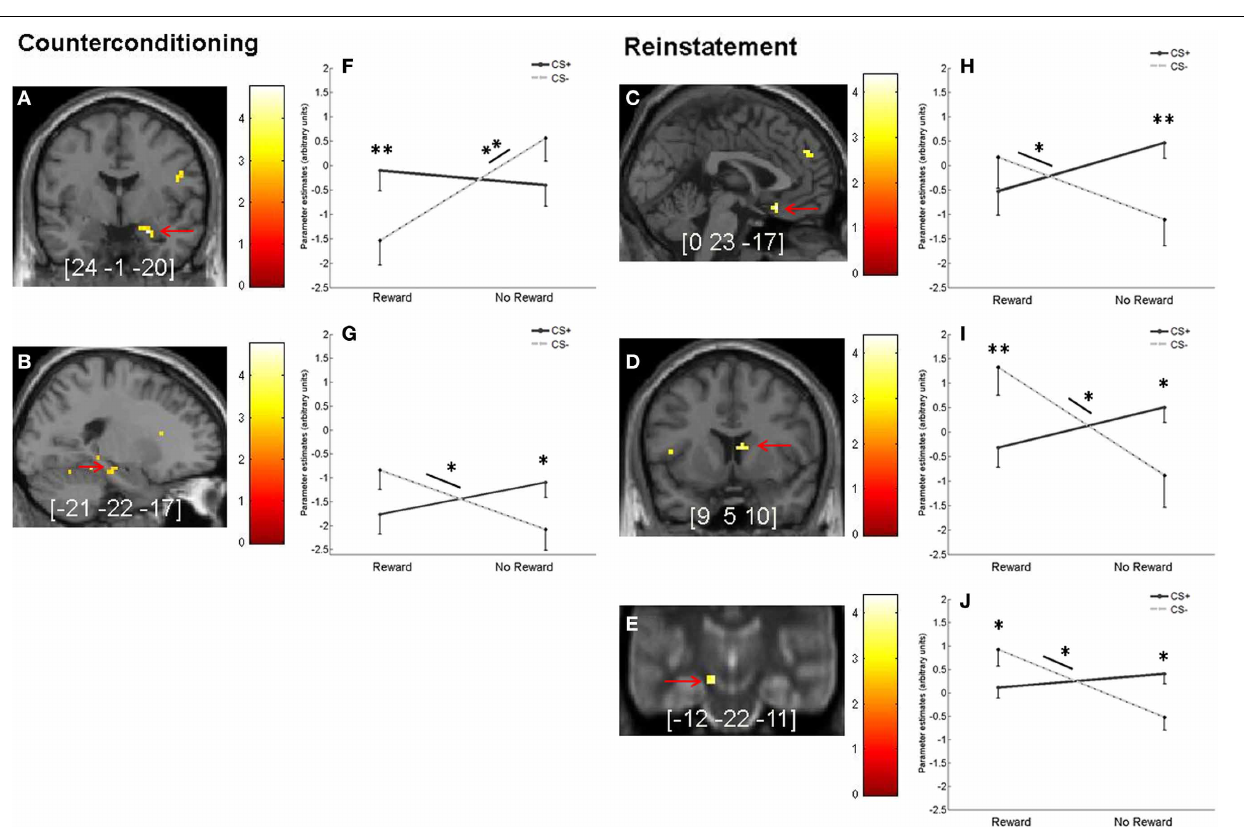
FIGURE 6 | Interaction of fear and reward during counterconditioning and reinstatement. (A,B) Interaction between reward status and previous fear association during counterconditioning in (A) right amygdala ( p < 0 . 05, SVC) and (B) left hippocampus (on a trend level, p = 0 . 06, SVC). (C–E) Significant interaction ( p < 0 . 05, SVC) between reward status and previous fear association during reinstatement in (C) OFC, (D) right caudate nucleus, and (E) left SN/VTA. (F–J) Mean parameter estimates (arbitrary units) from the peak